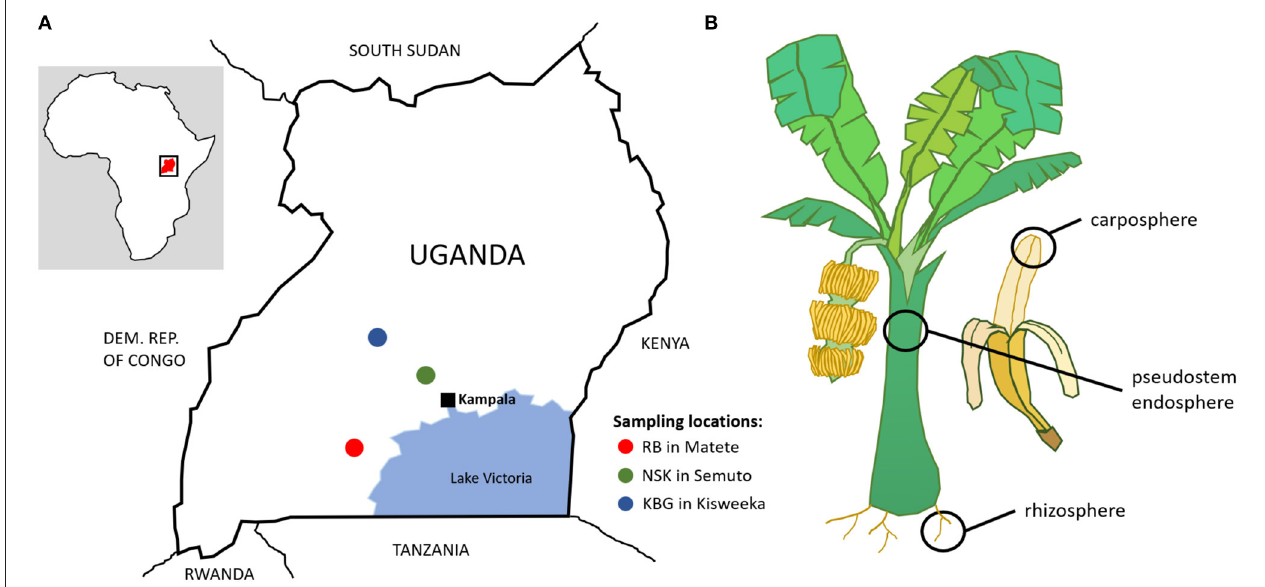
FIGURE 1 | Geographic location of sampling spots in Uganda (A) and schematic representation of samples (B)